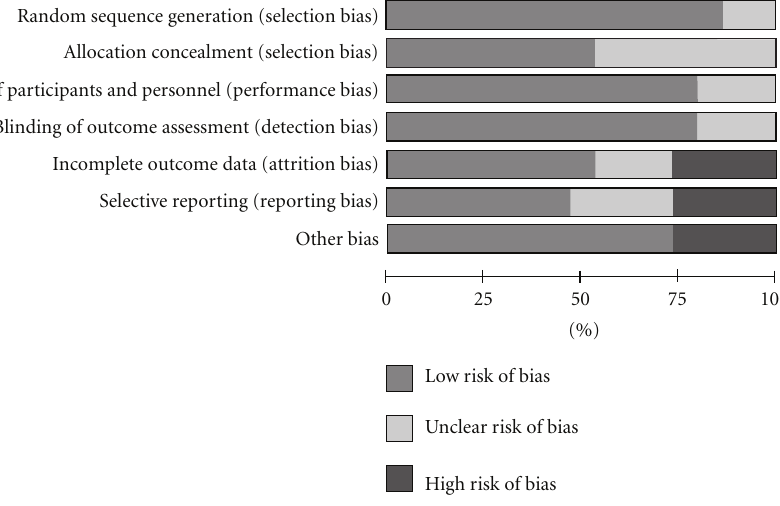
Figure 2: Quality assessment and risk of bias.